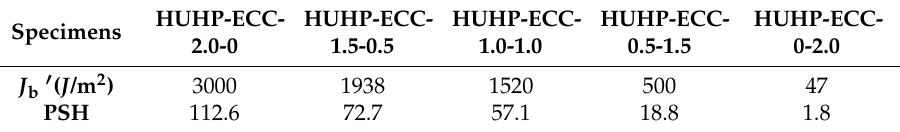
Table 7. Results of pseudo strain-hardening